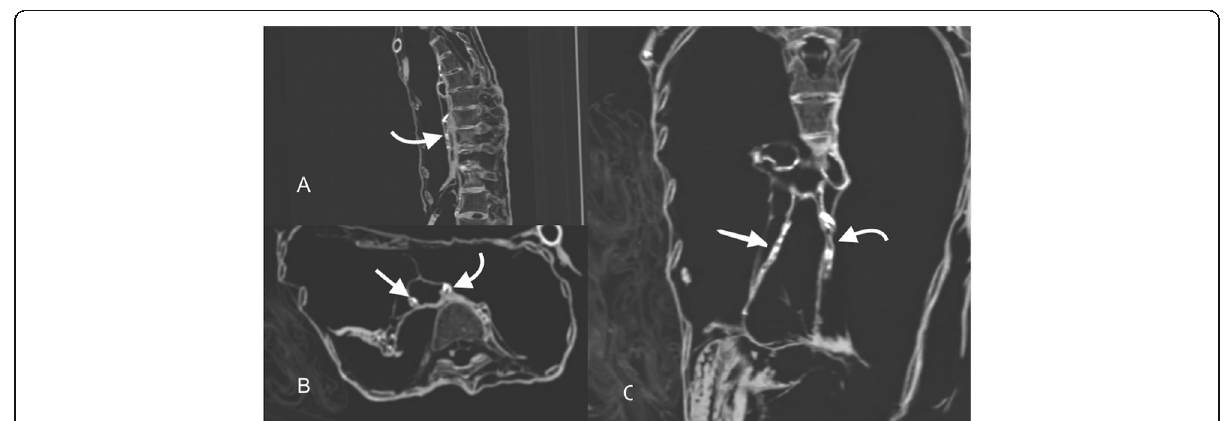
Fig. 8 Coronary atherosclerosis. Compiled CT images of “ Unknown-Woman-A ” mummy torso in sagittal plane ( a ), in axial ( b ), and in coronal plane ( c ). Presence of high-density calcifications within the course of the right coronary (straight arrow) and left coronary arteries (curved arrows) in multiple planes indicates severe atherosclerosis of the coronary arteries